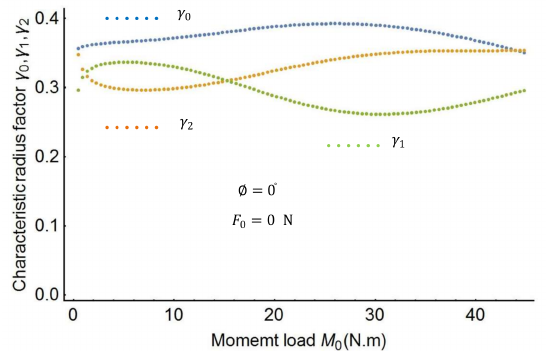
Figure 4. Characteristic radius factors as a function of the moment.